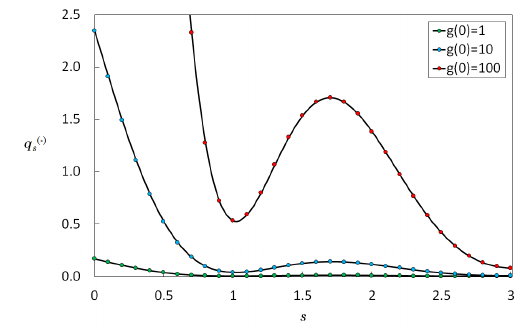
( − ) Figure 8. Dependence of the functions q s on s for different values of the amplitude of the coupling constant g ( 0 ) . The parameters w and ε are fixed and equal to w = 200 and ε = 0.5, respectively.